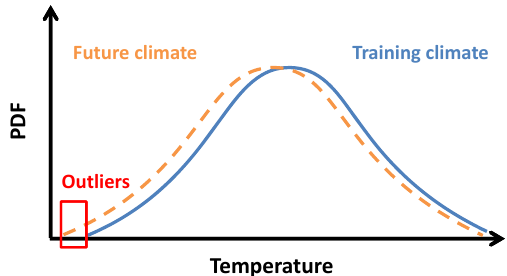
Figure 2. Schematic of a shift in the probability density function of stratospheric temperature in a future